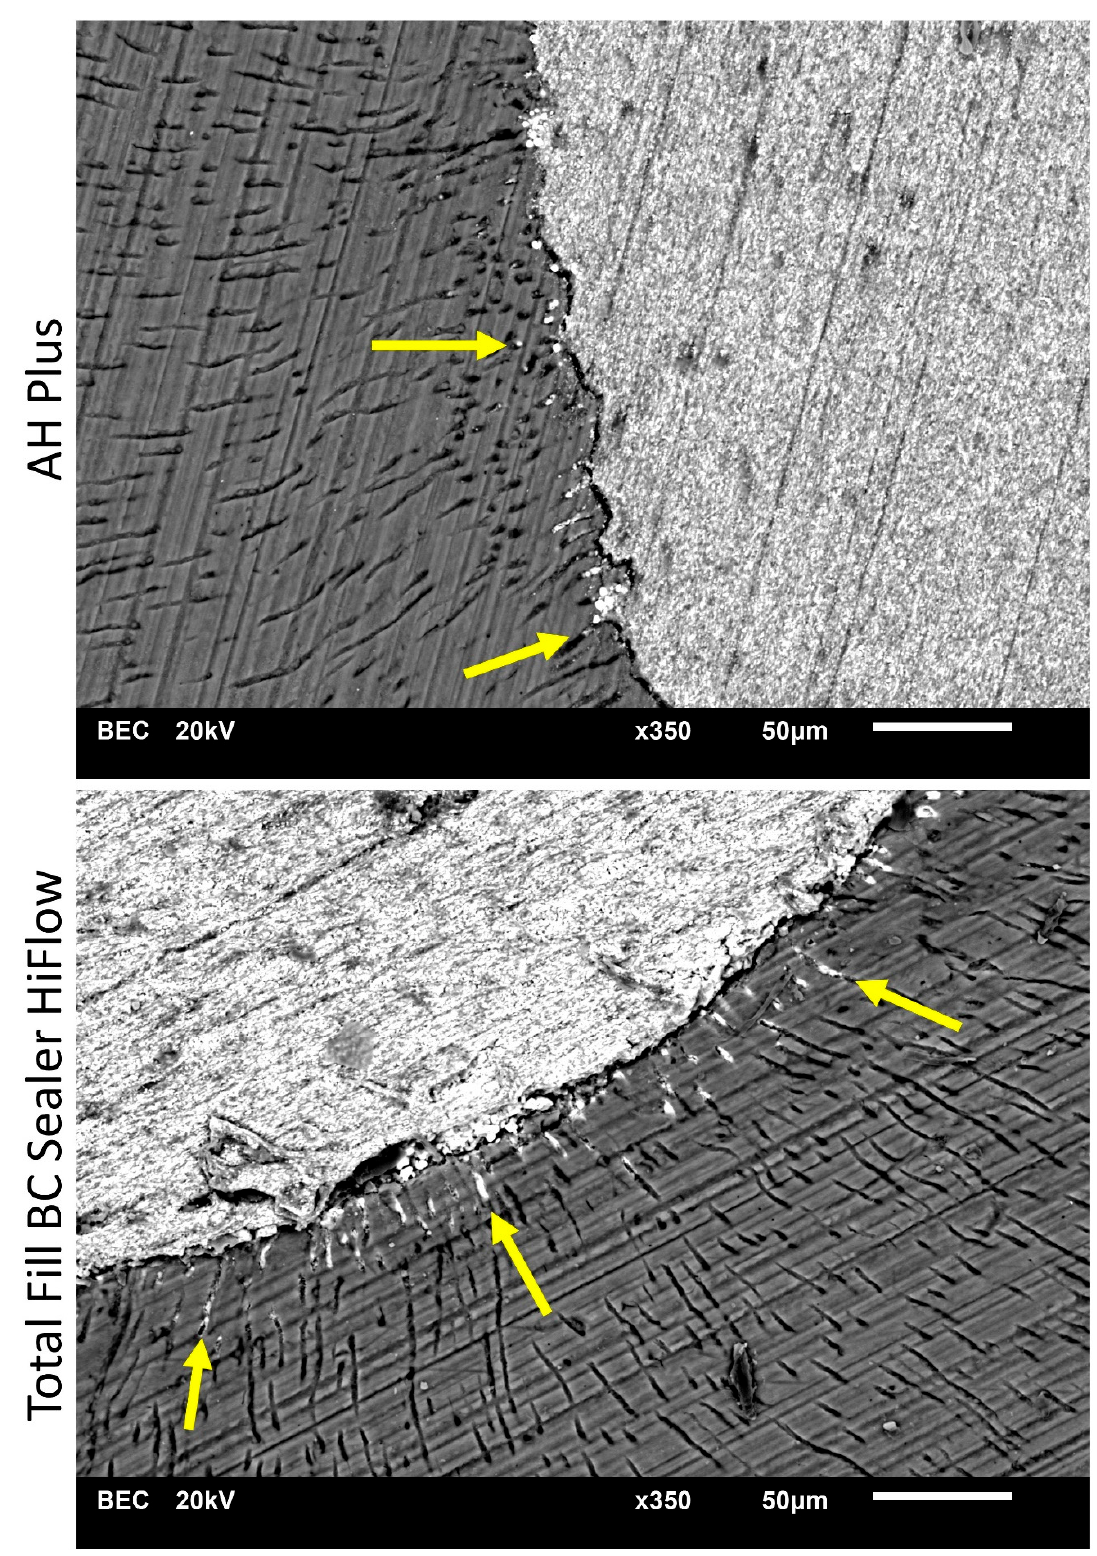
Figure 2. Scanning electron microscope (SEM) images display sealer penetration depth of AH Plus and Total Fill BC Sealer HiFlow after warm vertical root canal obturation at 5 mm from the root apex. Arrows indicating the sealer penetration depth found in SEM images.